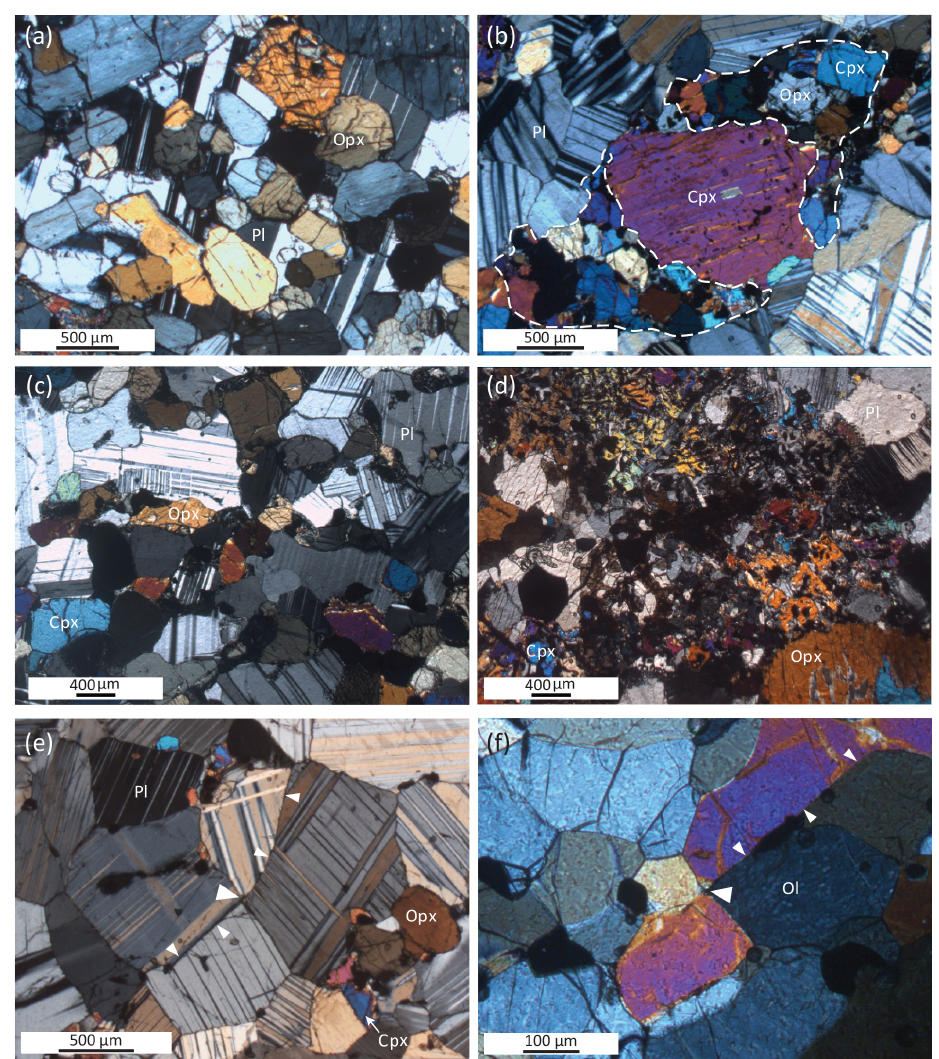
Figure 2. Typical microstructures in the San Quintín gabbroic and mafic granulite xenoliths. All photomicrographs are taken under crossed- polarized light. (a) Cumulate microstructure of the gabbroic xenolith SQL-13A characterized by crystallized pyroxenes and interstitial plagioclase. (b) Core-and-mantle microstructure of clinopyroxene in granulite xenolith SQW-75. The elongated cluster of clinopyroxene and orthopyroxene defines the foliation (upper right to lower left) in the granulite. White dashed lines describe the mantle of clinopyroxene and orthopyroxene recrystallized grains surrounding the clinopyroxene core. (c) Granoblastic microstructure with interlobate boundaries between plagioclase grains in xenolith SQW-110. (d) Melt patch between pyroxene and plagioclase aggregates in SQ-16. (e) Granoblastic microstructure in granulite SQW-75. Large plagioclase grains with straight grain boundaries (small white triangles) meeting at 120 ◦ triple junctions and at quadruple junctions (larger white triangle in the center). (f) Equigranular mosaic microstructure in lherzolite xenolith SQ-68. Quadruple junction (large white triangle in the center) associated with straight and aligned grain boundaries (described by the small white triangles) of olivine